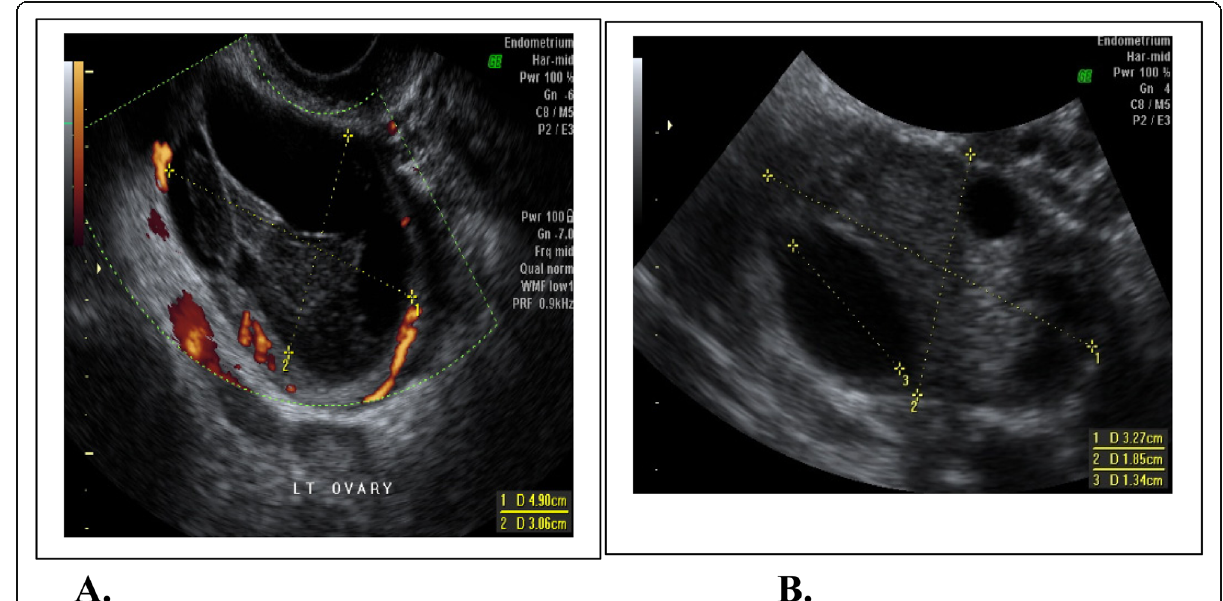
Fig. 4 GI-RADS 2 complex cyst. a The echogenic non-vascular part. b The regressive course on follow-up